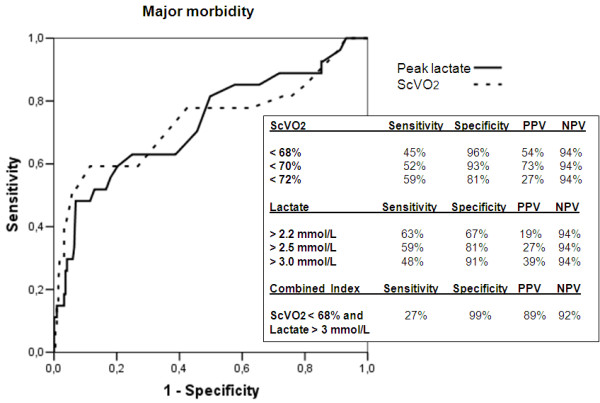
Receiver operating characteristic curve for major morbidity. Different cut-off values for nadir ScVO2, peak lactate, and a combined index are explored. PPV, positive predictive value; NPV, negative predictive value.